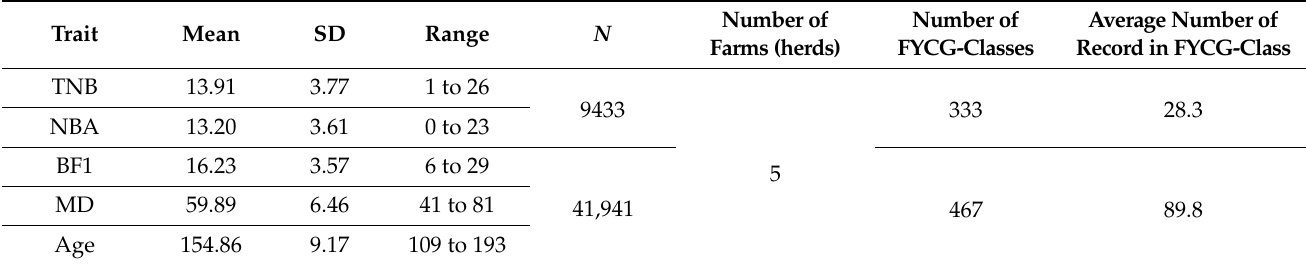
Table 1. The descriptive statistics of the whole